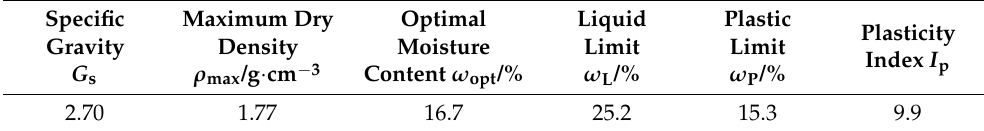
Figure 2. Test materials, ( a ) red mud, ( b ) lime, ( c ) loessial silt. Table 1. Basic physical properties of loessial silt.